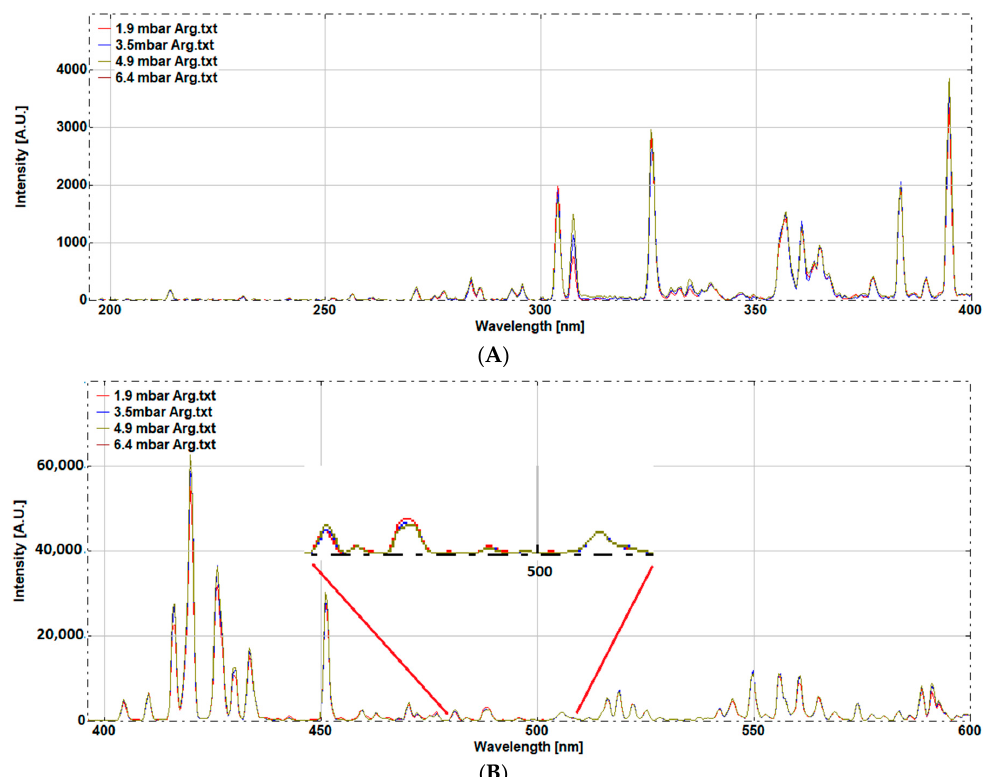
Figure 9. The effect of working gas pressure observed on the spectral plot (200 to 600 nm) of the plasma with IZO target and Argon gas only at various working gas pressures. When compared to the x and y plots in Figures 7 and 8, it can be seen that all we observe from the spectra is an increase in the intensity of certain peaks which makes the assessment of the data complex with further evaluation. All of these increases in intensity can be summarised as presented in Figures 7 and 8 by evaluating the colour of the plasma light. The inset in the second section of the plot demonstrates the complexity of analysing every single peak for the amount of slight increase in one of the peaks. ( A ): spectral plot 200 to 400 nm; ( B ): spectral plot from 400 to 600 nm.